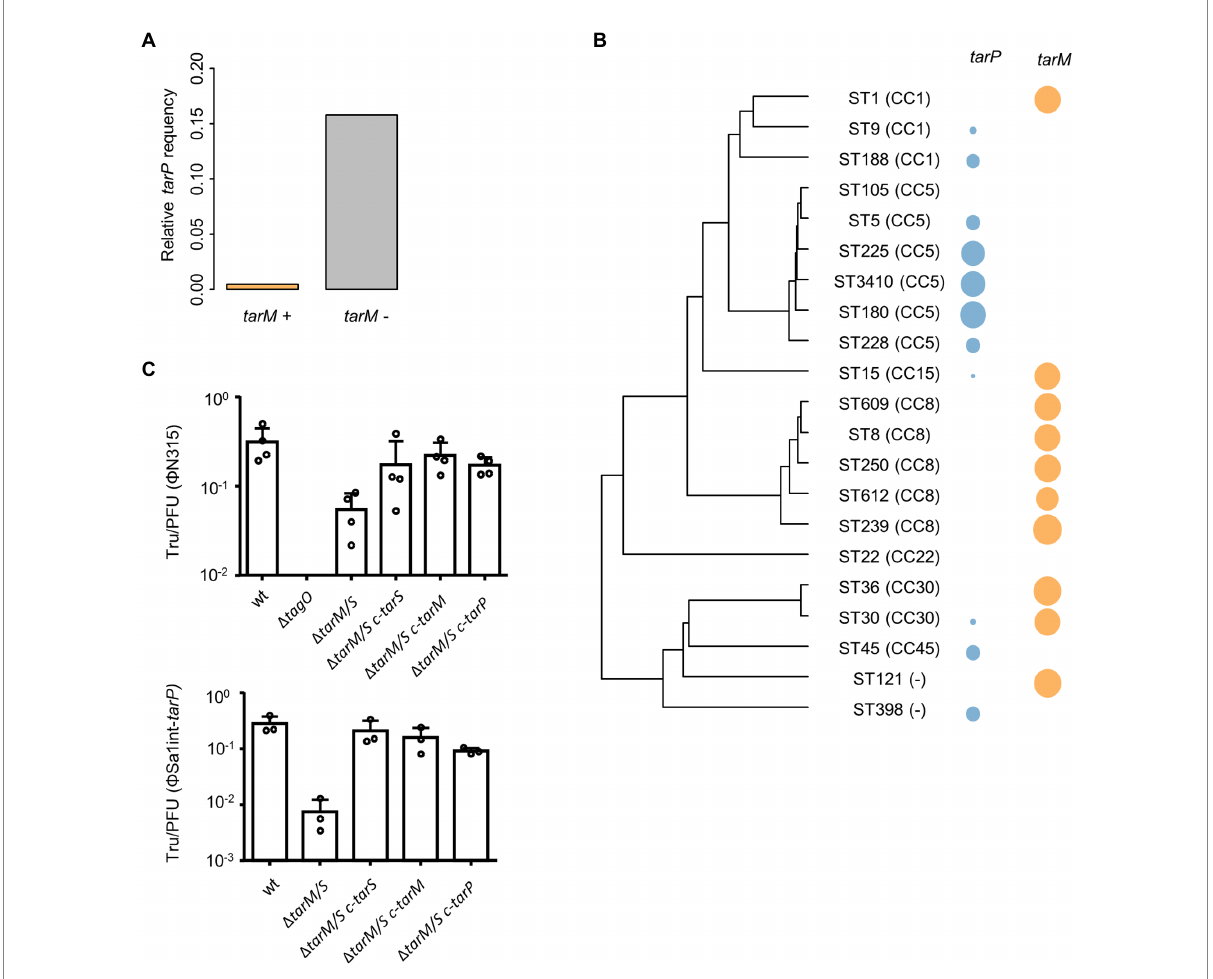
FIGURE 3 Influence of tarM on tarP phage prevalence. (A) Relative frequency of tarP presence in in dependence of tarM status. (B) Phylogeny based on concatenated MLST alleles for most prevalent STs. Relative frequency of tarP and tarM are indicated by colored circles. (C) Transfer rates of tarP phages into RN4420 WTA mutant panel. RN4220 WT, RN4220 WTA mutant ( Δ tagO ) , and WTA glycosylation mutant RN4220 ( Δ tarM / tarS ) expressing different WTA GTs. Transfer rates are represented as obtained transductants per input PFU of the respective phage. Top, transfer of phage Φ N315 (mean + s.d. of 4 independent experiments). Bottom, transfer of phage Φ Sa1int- tarP (mean + s.d. of 3 independent biological